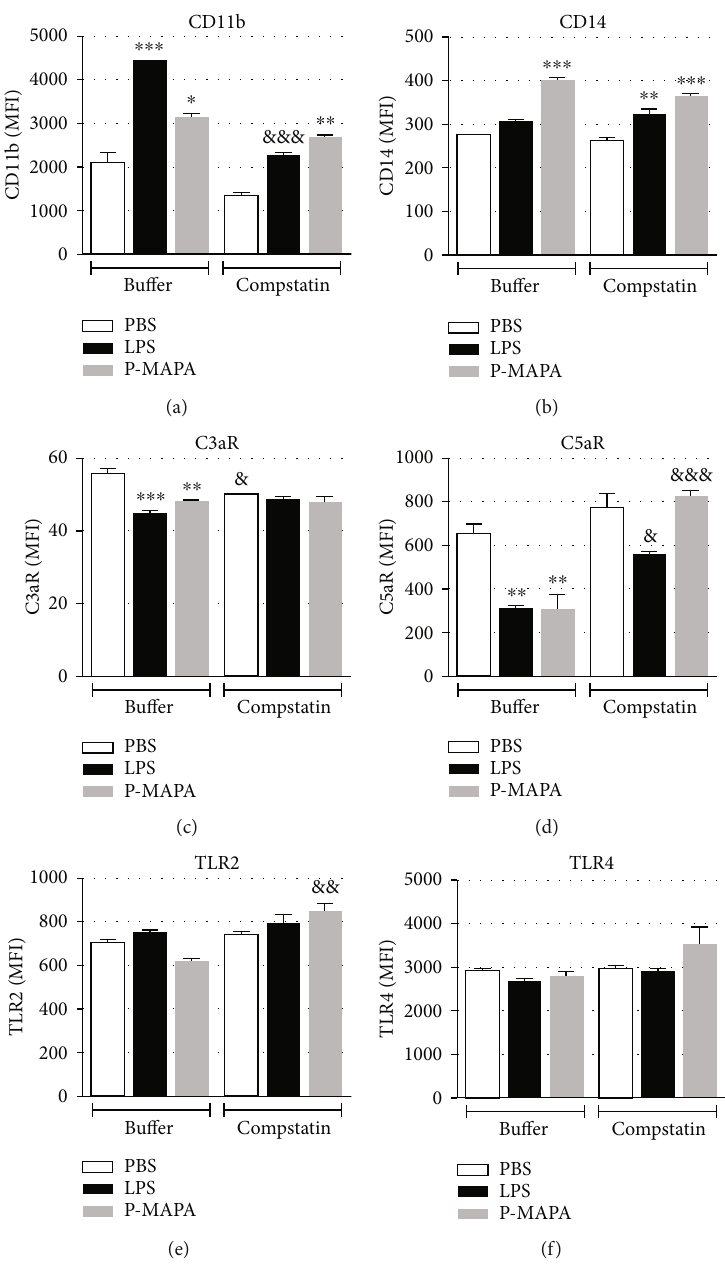
Figure 5: Expression of surface receptors following inhibition of complement activation by compstatin. Blood samples were incubated with compstatin (1 mM) (10 min, RT) ahead of stimulation with PBS, LPS (100 μ g/mL), or P-MAPA (1000 μ g/mL) for 30 minutes at 37 ° C. Next, erythrocytes were lysed, and leukocytes were stained for fl ow cytometry analysis. (a) CD11b, (b) CD14, (c) C3aR, (d) C5aR, (e) TLR2, and (f) TLR4 expressions. Data are representative of three separate experiments, from three di ff erent donors, performed in duplicate, and the results are expressed as the mean ± SEM . Comparison between treatments was analyzed using ANOVA and Tukey ’ s posttest. ∗ p < 0 : 05 , ∗∗ p < 0 : 01 , ∗∗∗ p < 0 : 001 , and ∗∗∗∗ p < 0 : 0001 : signi fi cant di ff erences between the mean values with PBS control. Comparison between samples treated with compstatin or not (bu ff er) was analyzed using Student ’ s t -test, and signi fi cant di ff erences are represented by & p < 0 : 05 , && p < 0 : 01 , and &&& p < 0 : 001